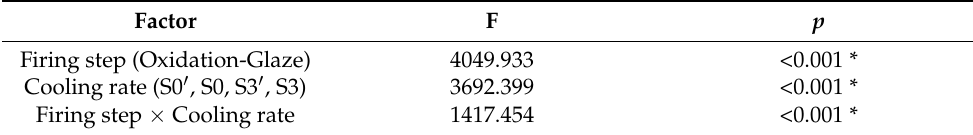
Figure 2. Change in the hardness during multiple firing. Table 5. Analysis of the main and interaction effects on hardness by a RMANOVA.